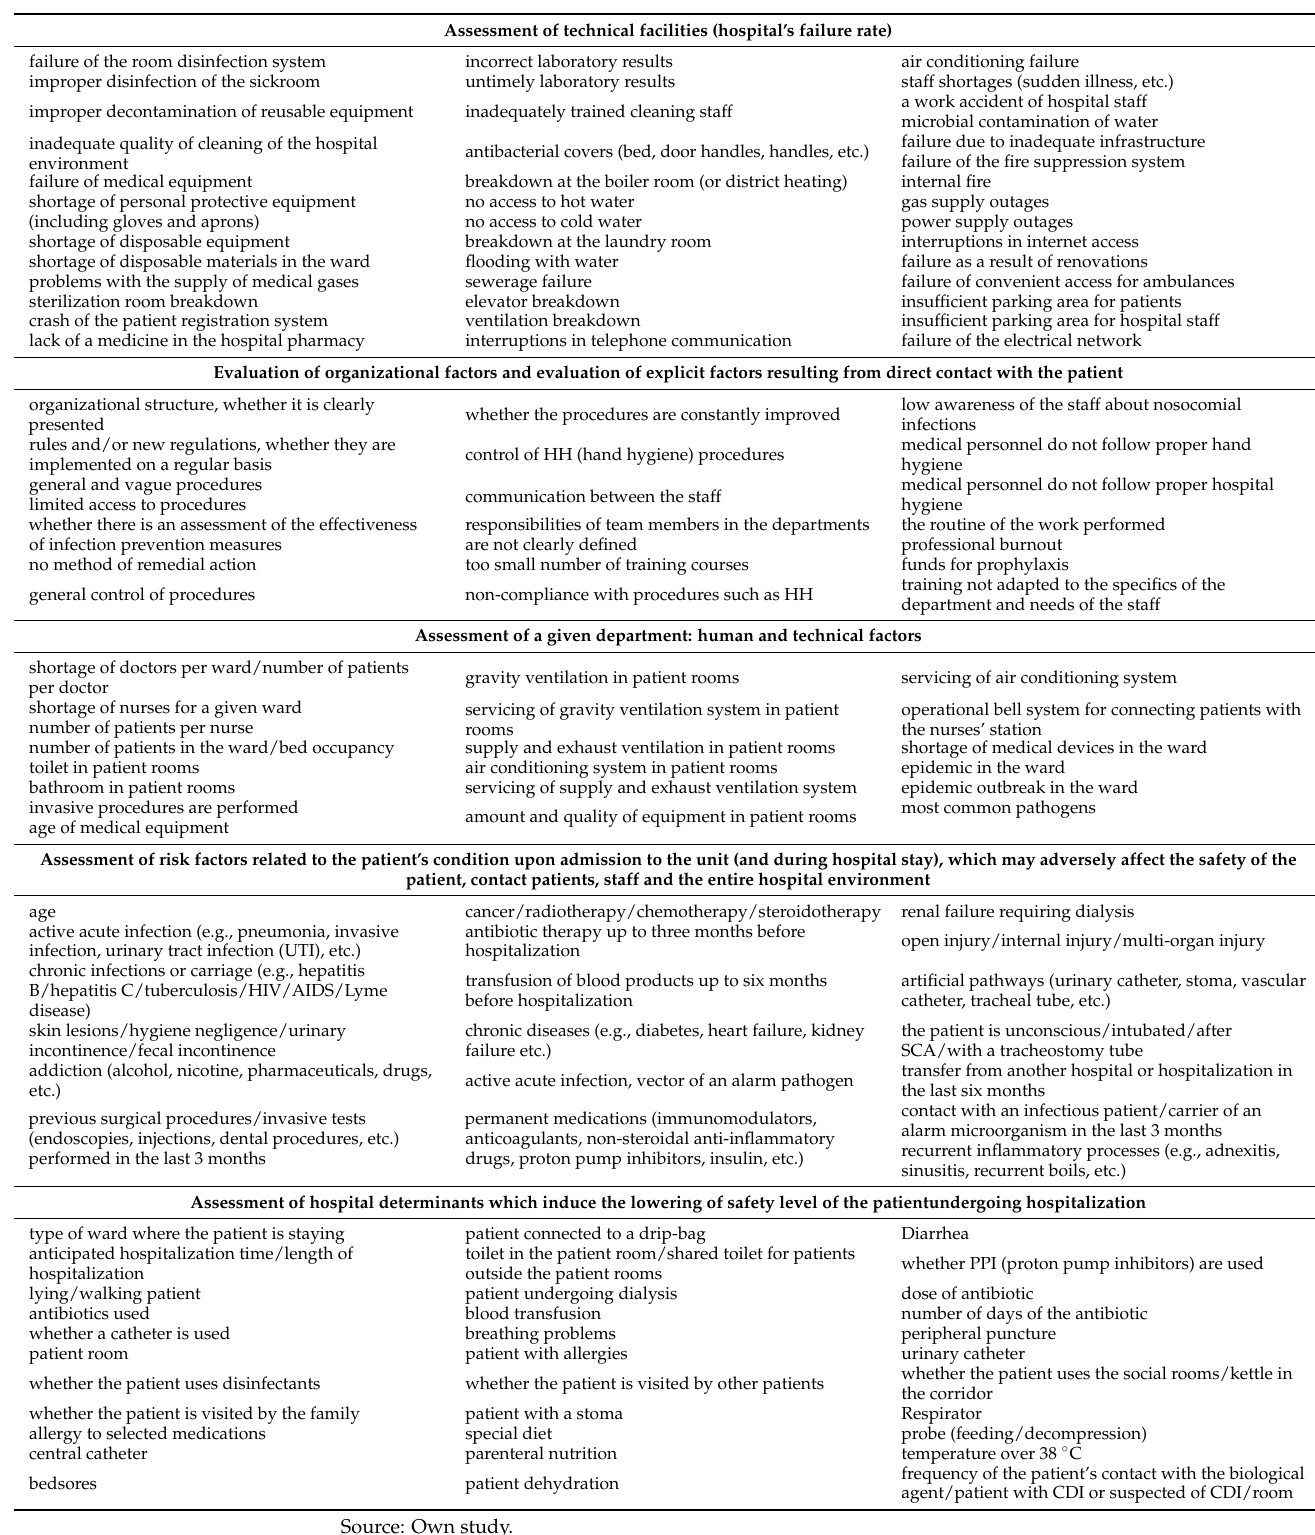
Table 1. Examples of events/factors related to the infrastructure and management of a medical